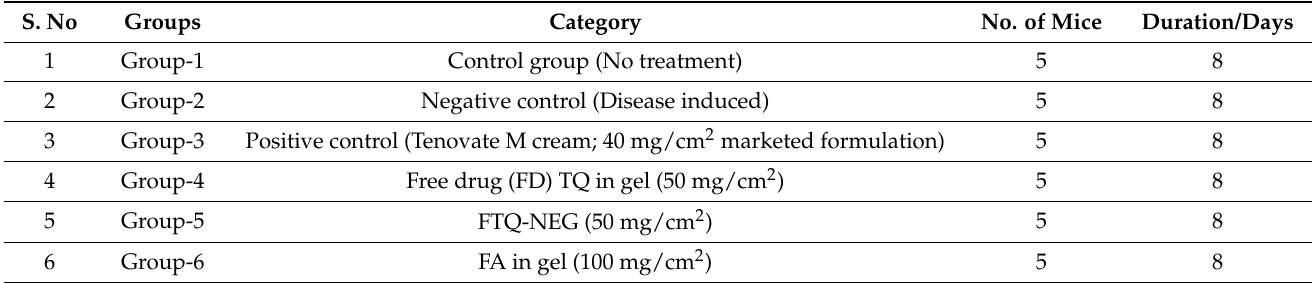
Table 2. Groups of animals (n =